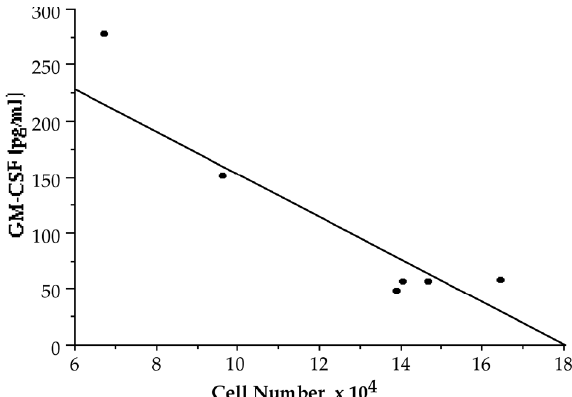
FIG. 2. Relationship between cell number and GM-CSF production. Data were obtained from human ASMC grown under various serum conditions and then stimulated with IL– 1 b and TNF- a (10ng/ml) for 24h ( r =0.948; p =0.004).